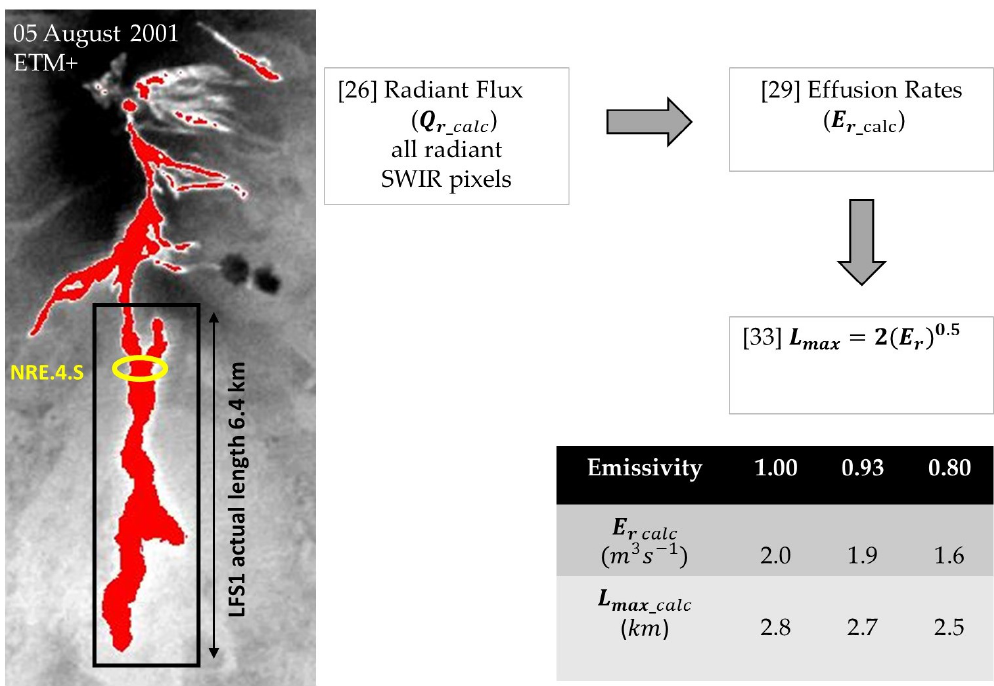
Figure 7. ETM+ scene obtained on 5 August 2001 highlighting the high-temperature thermal anomaly, focusing on an individual LFS1 flow analyzed in this study and detailing a flow chart of procedures followed to obtain the maximum lengths that LFS1 lava flow can reach using the empirical approach [33,34]. The table shows the difference in results using various emissivity values (0.80, 0.93, and